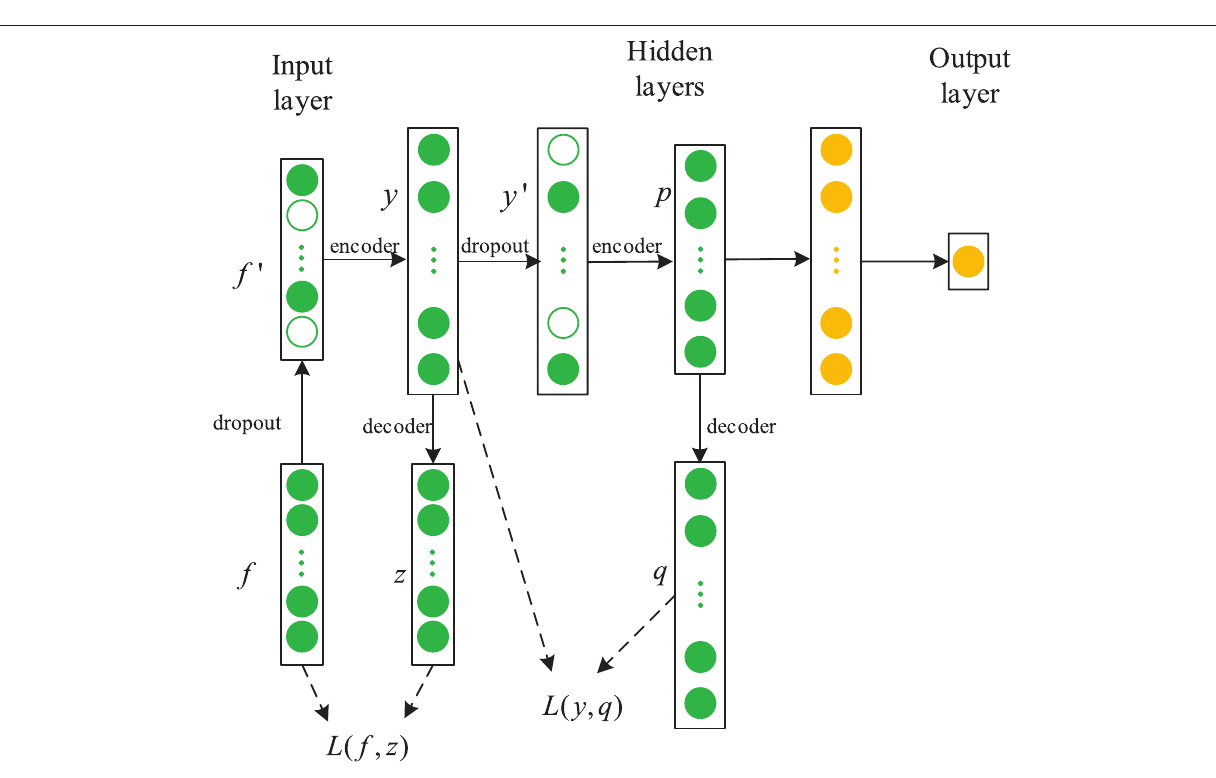
FIGURE 4 | Structure of an SDAE-LSTM network. The green circles represent the layers of SDAEs and the yellow circles are LSTM layers. f ′ represents the corrupted input features, y represents the encoded data, and L is a squared loss